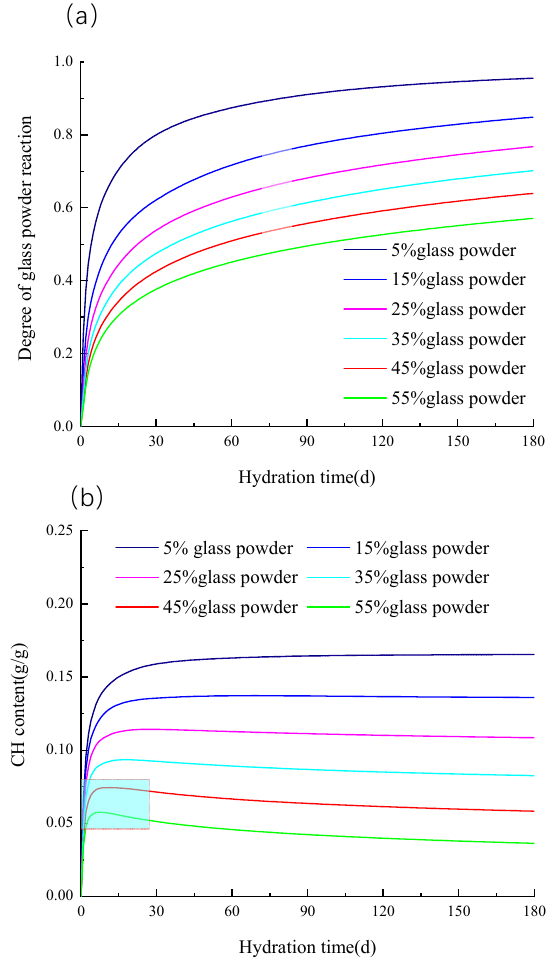
Figure 7. The reaction degree of glass powder and CH content changed with the reaction time. ( a ) the degree of glass powder reaction ( b ) CH content.